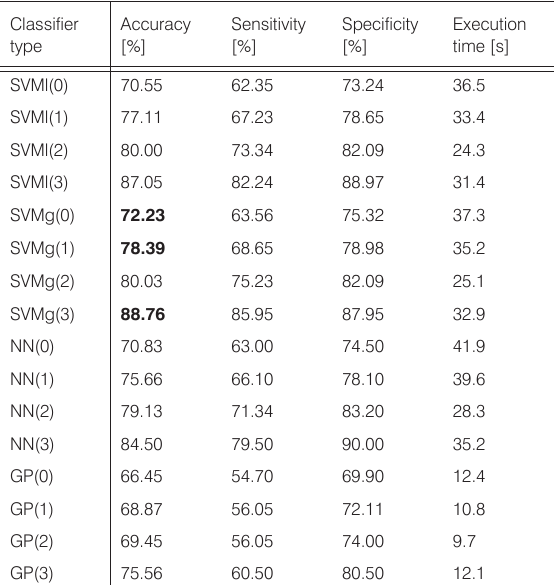
Table 1. Comparison of classification prediction performances for different